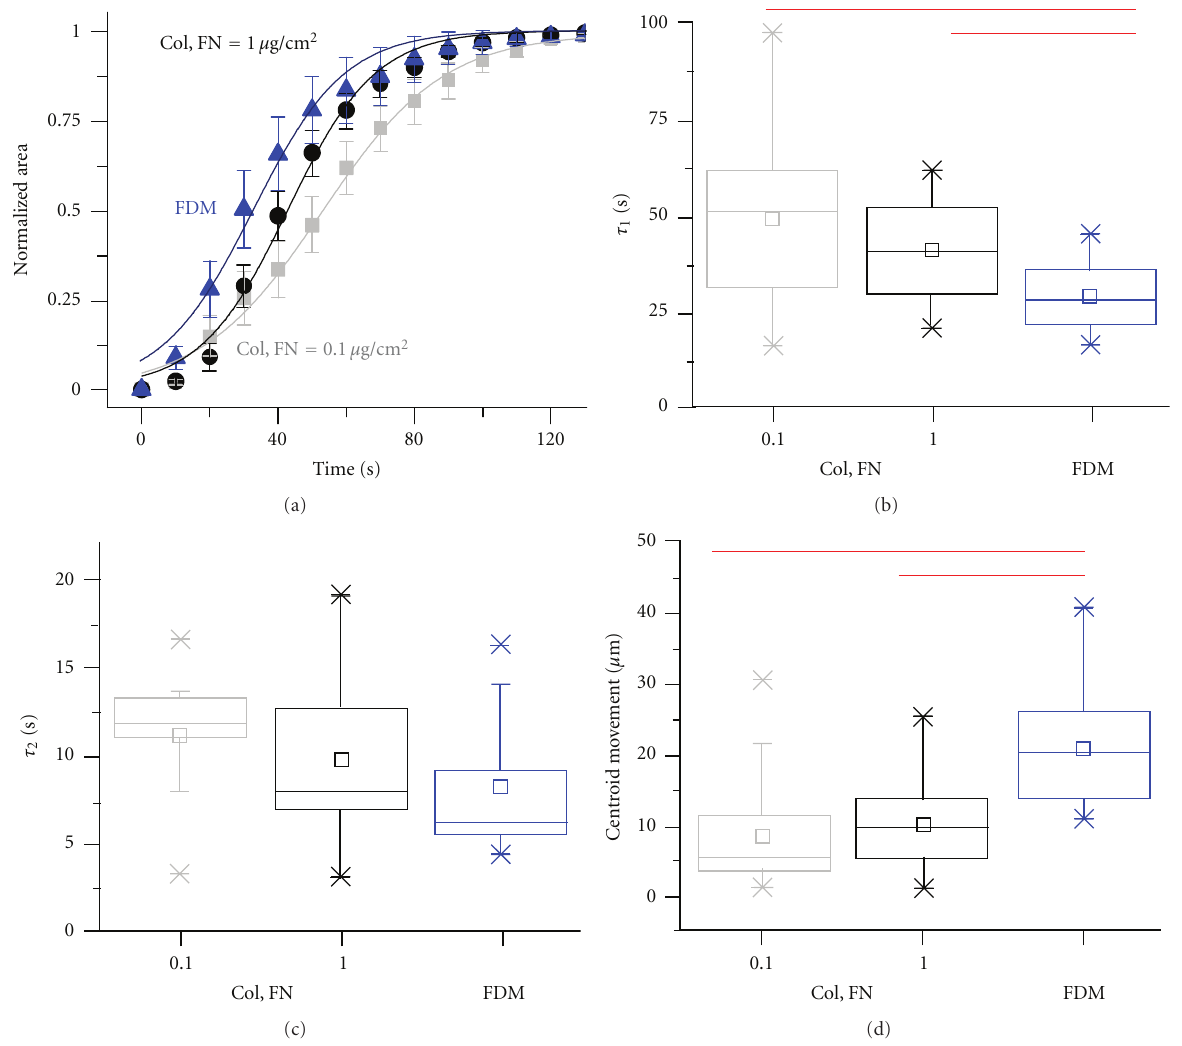
Figure 8: Deadhesion dynamics of MDA-MB-231 cells on mixed ECM surfaces. (a) Quantification of cell shape changes during deadhesion on ECM surfaces of varying composition. Plots of normalized cell area for cells cultured on coverslips coated with Col, FN = 0 . 1 μ g/cm 2 , Col, FN = 1 . 0 μ g/cm 2 , and on FDMs. ((b), (c)) Box whisker plots of retraction time constants of cells plated on mixed ECM surfaces. Increase in coating density led to faster deadhesion, with the fastest deadhesion observed on FDMs ( ∗ P < 0 . 05). (d) Box whisker plots of centroid movement of cells during deadhesion on mixed ECM surfaces. While centroid movement remained unchanged on the two di ff erent Col/FN surfaces, significantly higher centroid movement was observed on